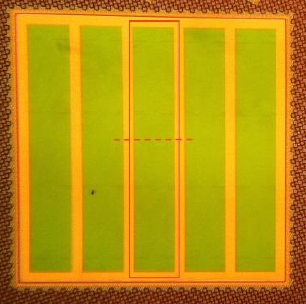
Figure 15. Photograph of the color-sensor test structure including indication of one sensor stripe and cut-line for cross-section.